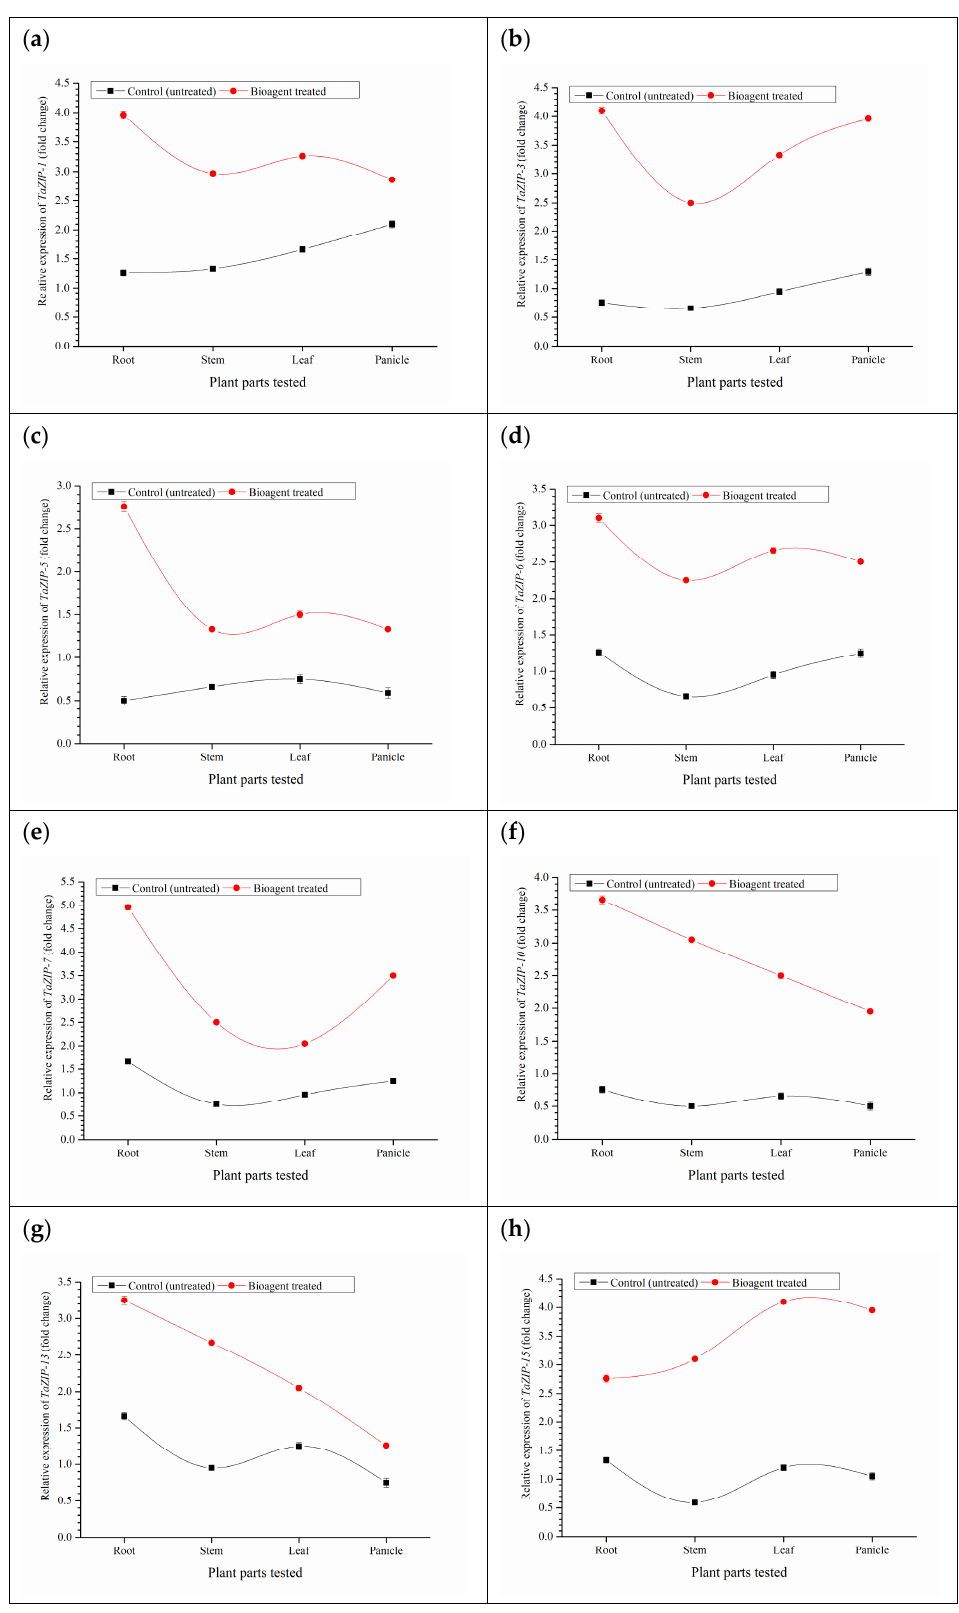
Figure 4. Effects of microbial inoculation on expression profile of ZIP transporter genes (fold change) in the wheat grown in saline sodic soil at 90 DAS, ( a ) TaZIP - 1 , ( b ) TaZIP - 3 , ( c ) TaZIP - 5 , ( d ) TaZIP - 6 , ( e ) TaZIP - 7 , ( f ) TaZIP - 10 , ( g ) TaZIP - 13 , and ( h ) TaZIP-15. Data are means and vertical bar represents standard